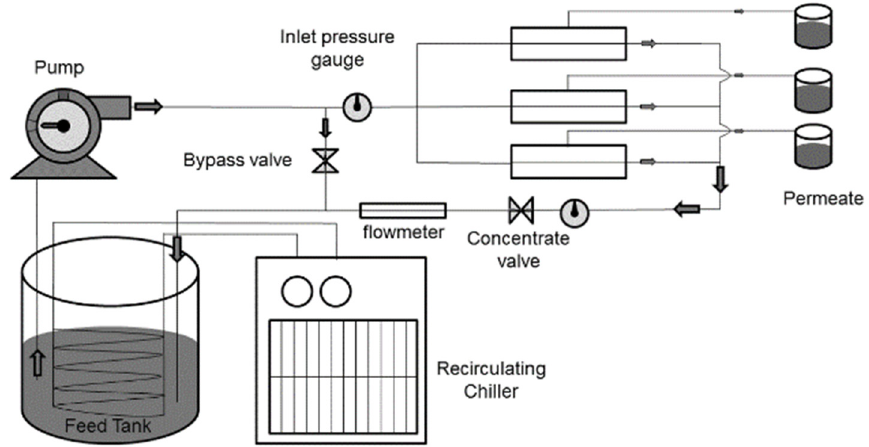
Figure 3. Schematic of bench-scale cross-flow membrane filtration setup.